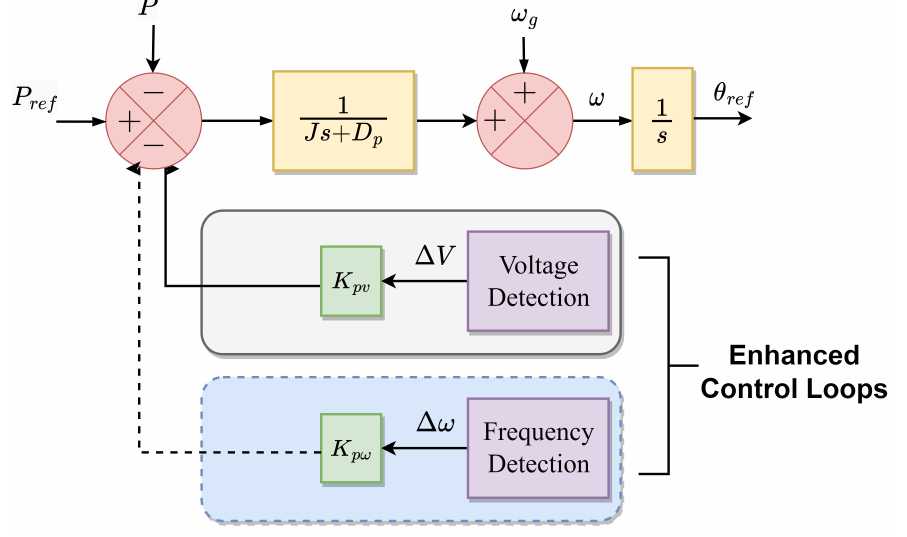
Figure 18. Reducing active power references [80,87].